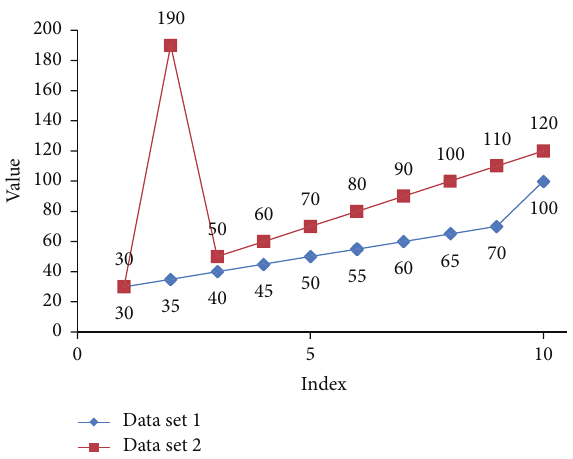
Figure 1: Two data sets, each containing one outlier which cannot be located by Grubbs test. The outlier in data set 1 is the last element of the series and considerably deviates from the expected value. The outlier in data set 2 is the maximum of the series, but it is not the first or last